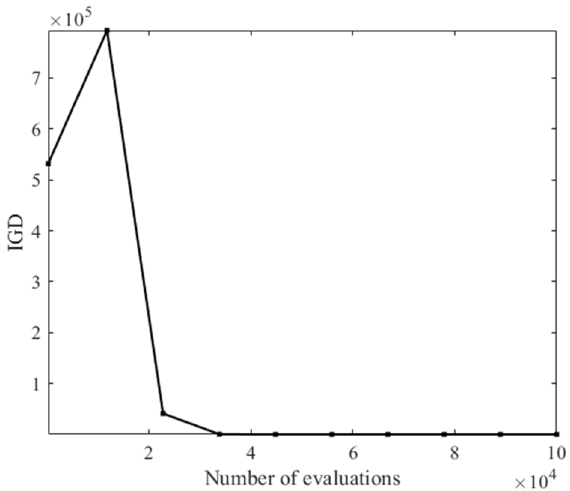
Figure 3. Change of IGD value with the number of assessments (5 objective).